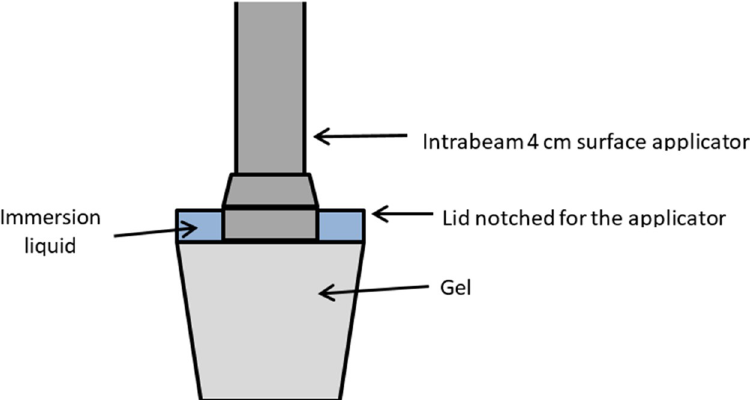
Fig 1. Irradiation configuration with plastic